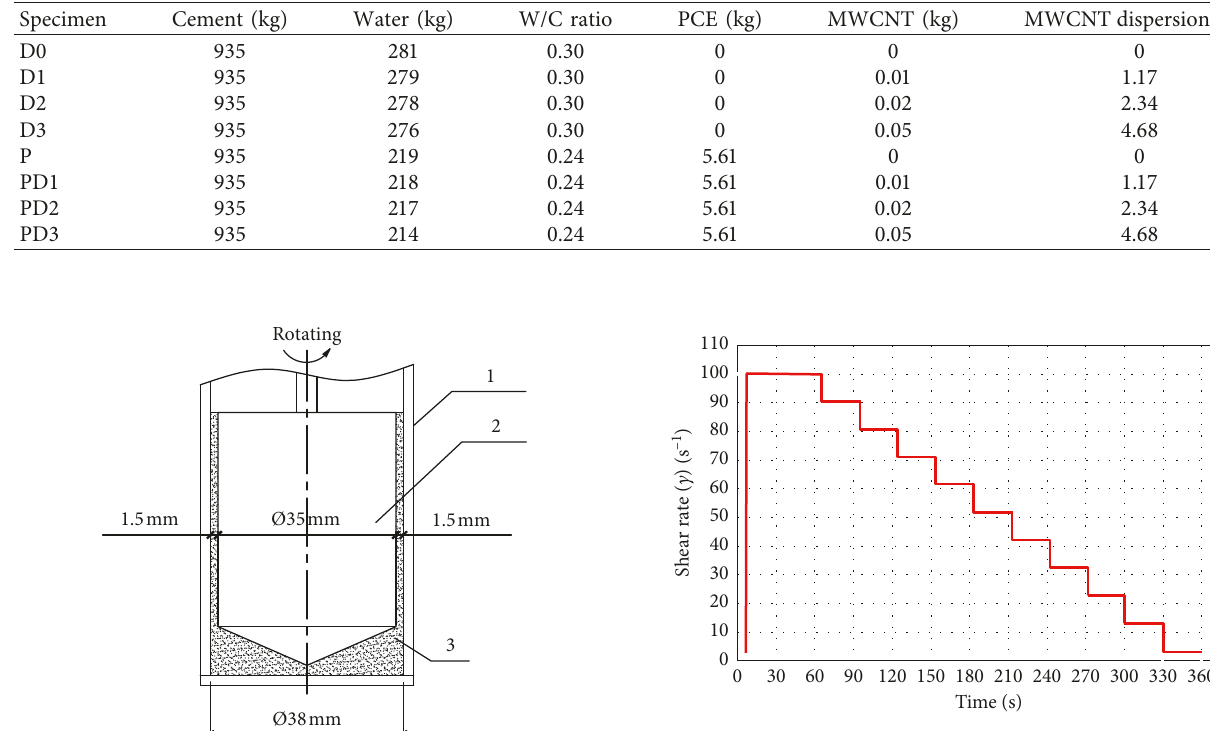
Table 3: Content of materials for 1m 3 in tested cement pastes.